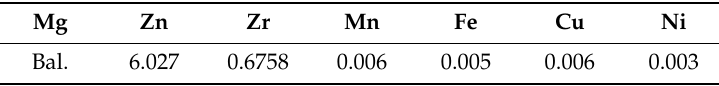
Table 1. Chemical components of magnesium alloy ZK60 in wt%.